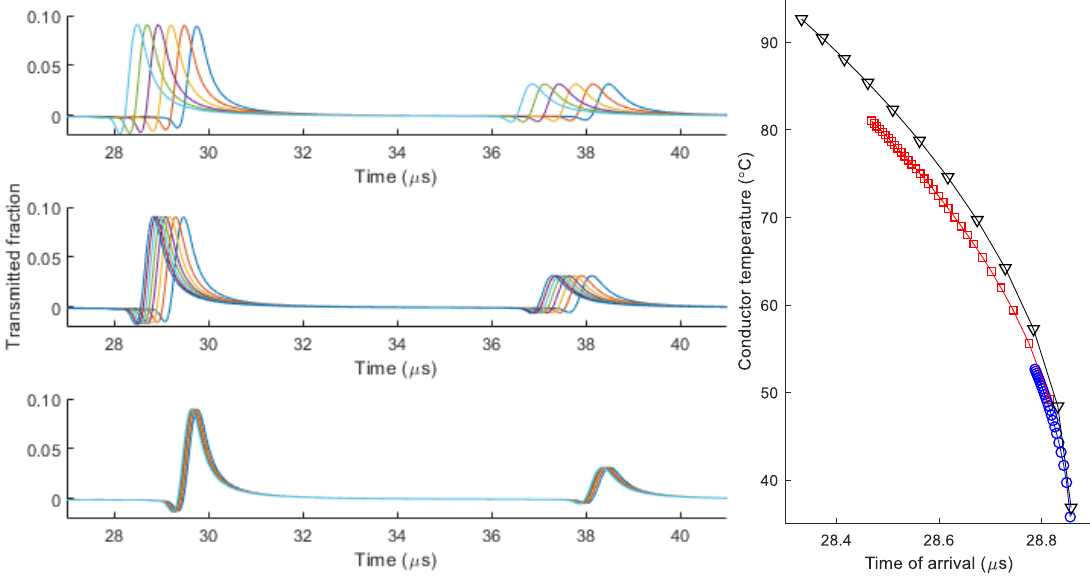
Figure 10. Relationship between temperature and signal time of arrival for the following: up to 3 h with 1 3 ⁄ 4 times nominal current (top waveform and black triangles), 4 days with 1 1 ⁄ 4 times nominal current (middle waveform, red squares) and 3 days with nominal current (bottom waveform, blue circles); the black markers represent samples taken every quarter of an hour, the red and blue markers every three hours.